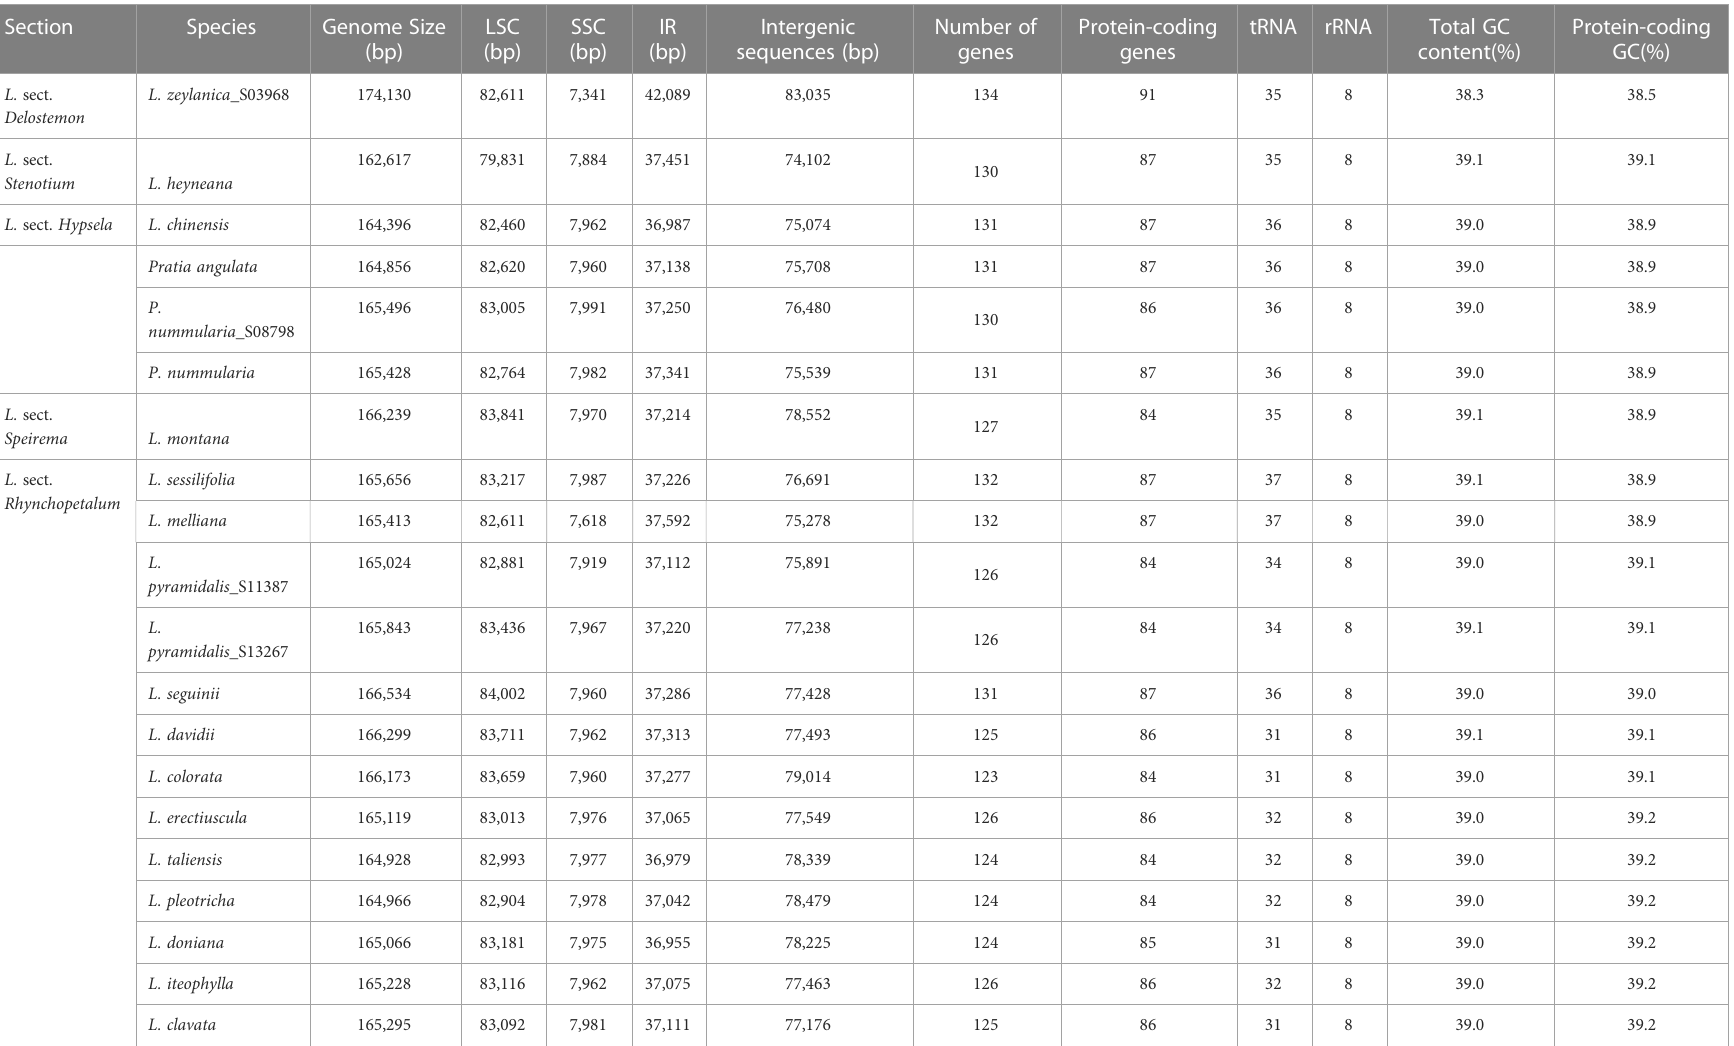
TABLE 1 Assembly information of twenty plastomes of East Asian lobelias.